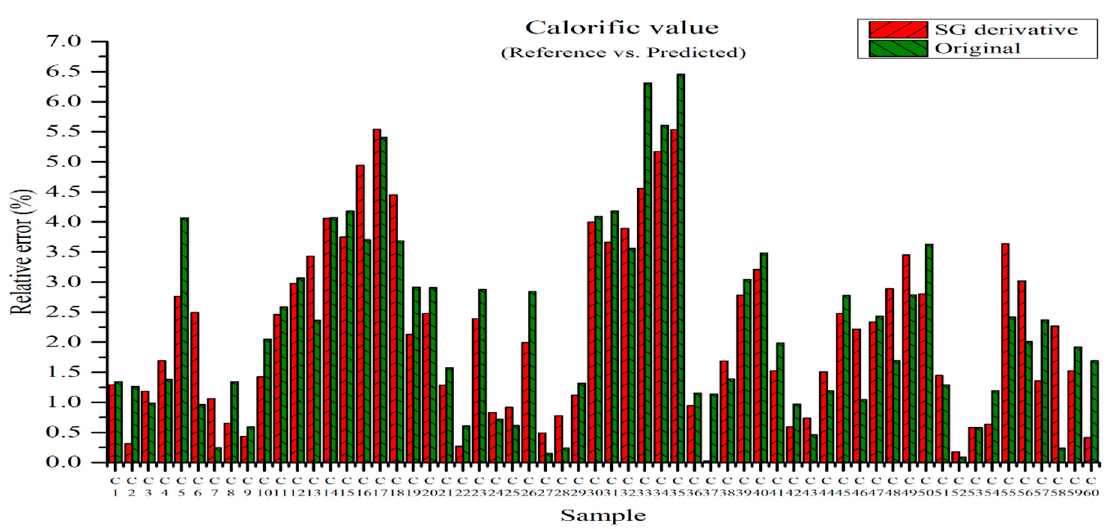
Figure 16. Relative errors between measured and predicted values for the PLSR model of the original data and the PLSR model pre-processed by SG derivative.